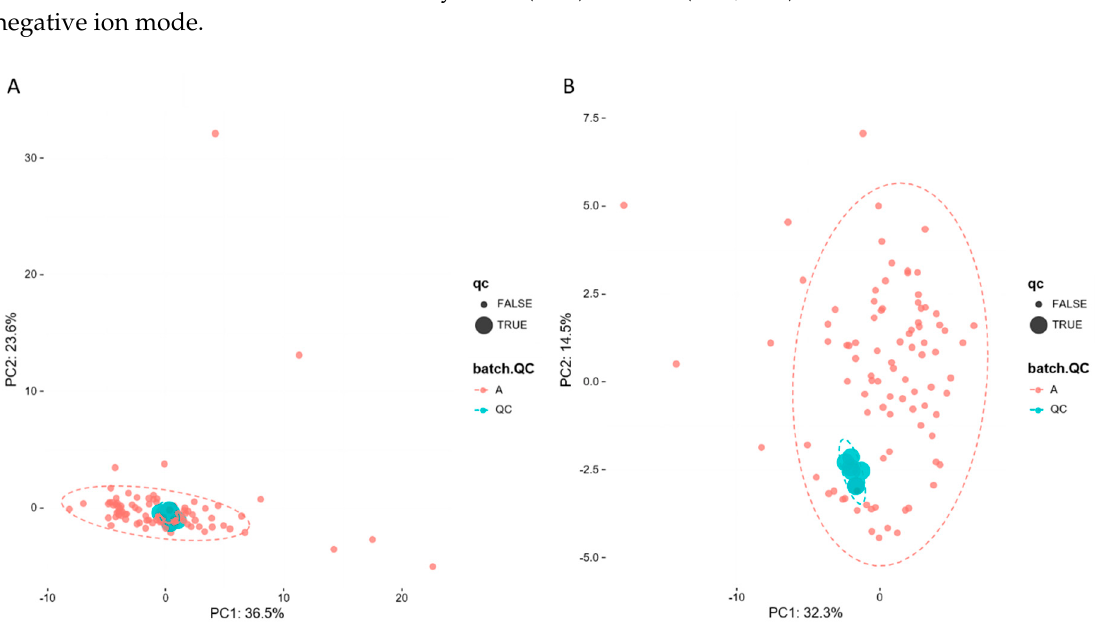
Figure 4. PCA of lipids in BALF of mice: ( A ) positive ion mod; ( B ) negative ion mod. 2.3.3. Analysis of Differential Lipid Metabolites The U-test and FDR calibration were used to find the differential lipids in the BALF of control group and that of ALI model group. p < 0.05 and FDR < 0.2 were selected for the selection of differential lipids. In the positive ion mode, 11 differential lipids were obtained, e.g., lysoPC, PC,